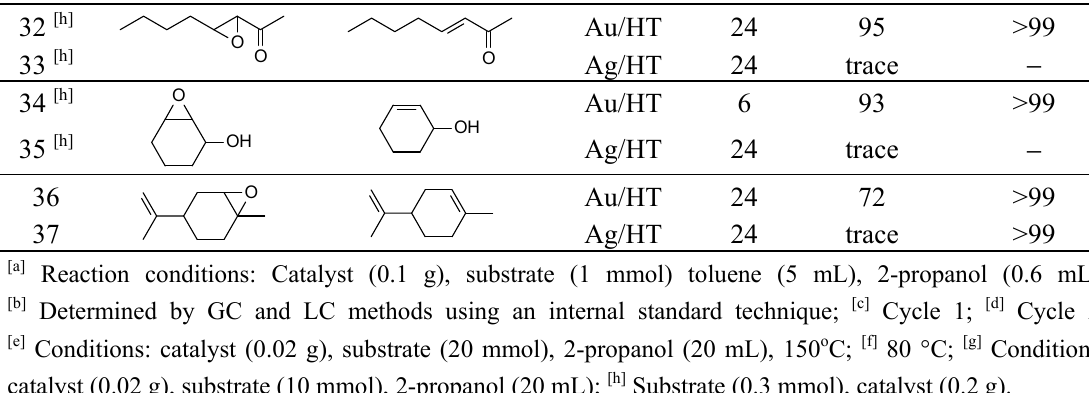
over basic sites (BS) and deoxygenation of 2